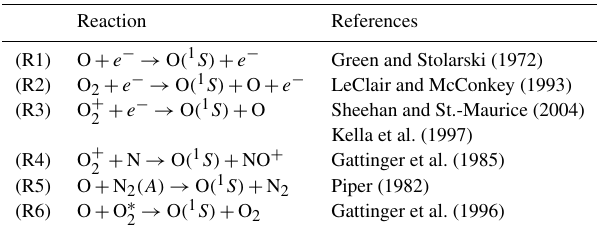
Table 2. Reactions producing O( 1 S ) included in the Southampton ionospheric